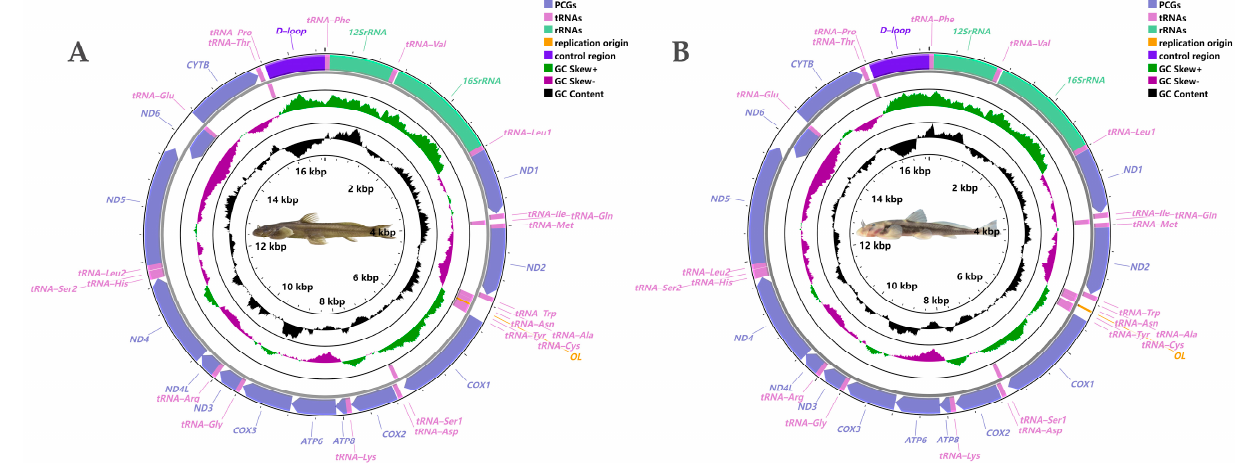
Figure 1. Physical mitogenome maps of Exostoma tibetanum ( A ) and Exostoma tenuicaudatum ( B ), drawn to scale, as indicated by the innermost circle. Genes encoded on the heavy or light strand are shown outside or inside of the outermost circle, respectively (arrows indicate the direction of gene transcription). The intermediate purple–green ring indicates the GC skewness (purple and green peaks indicate the positive and negative values, respectively). The GC content is plotted using a black ring, showing the deviation from the average GC content; PCGs—protein-coding genes, tRNAs—transfer RNA genes, rRNAs—ribosome RNA genes. Table 2. A + T contents and AT/GC skewness of the mitochondrial genomes of Exostoma tibetanum and Exostoma tenuicaudatum .